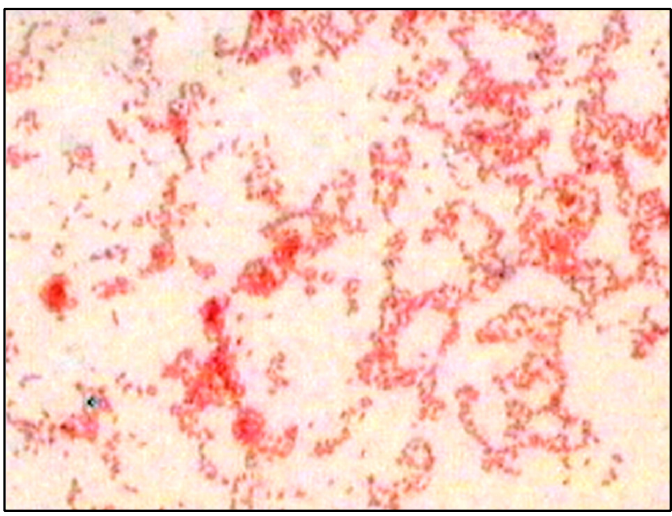
Figure 1. Microscopic observation of Sudan black B stained smear of Alcaligenes sp. RZS4 showing the presence of refractile PHB granules .